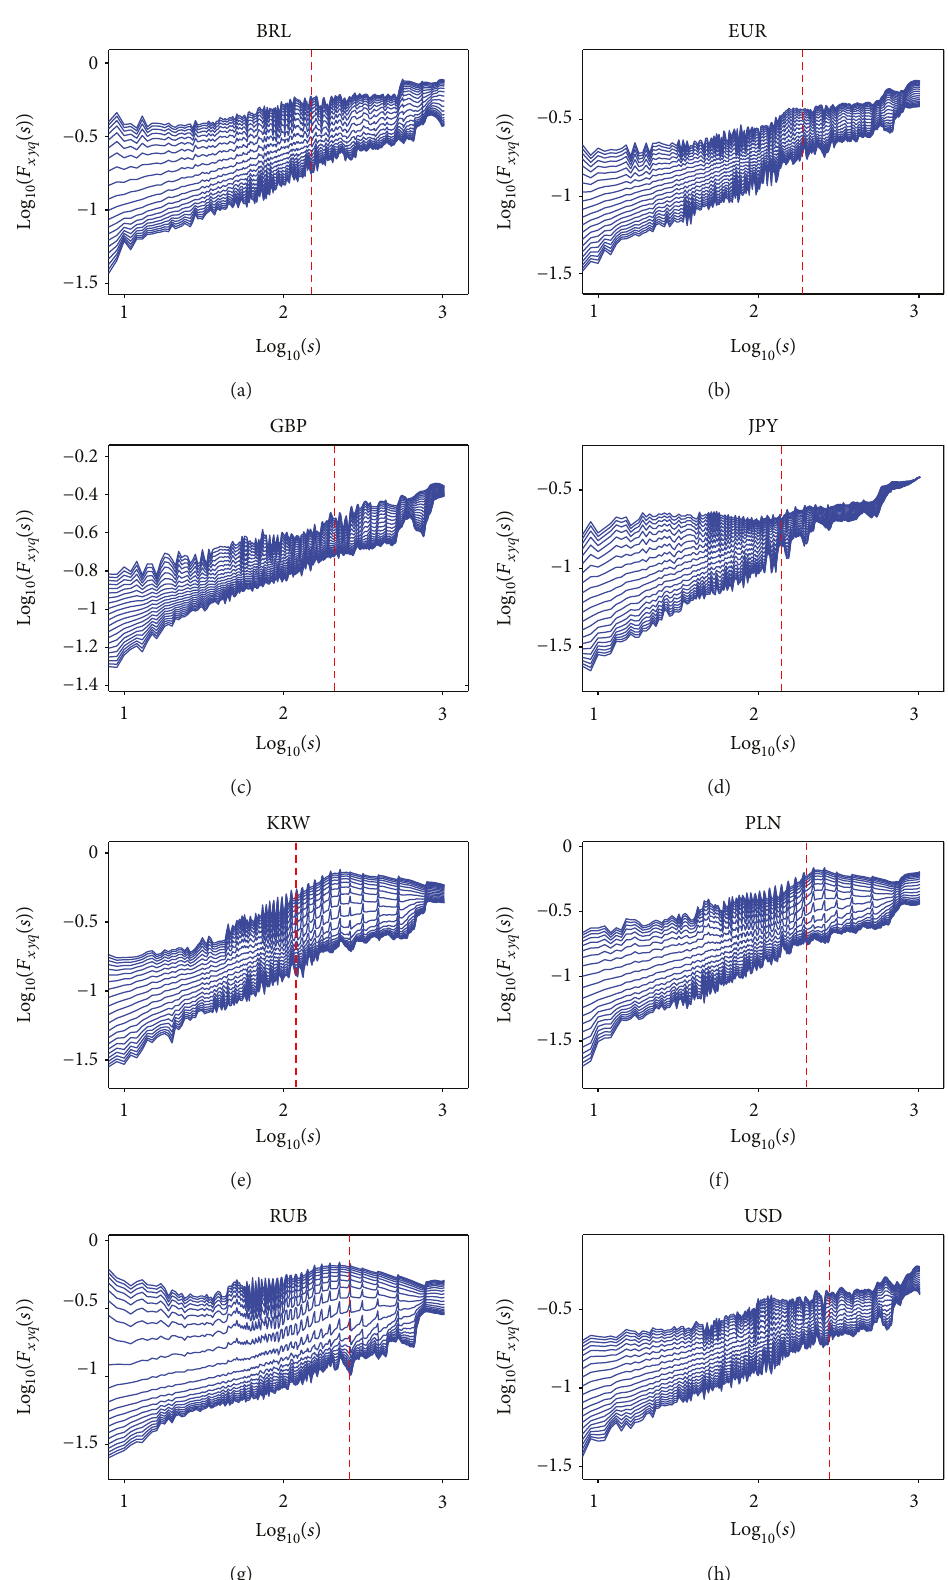
Figure 5: The log-log plots of fl uctuation function F